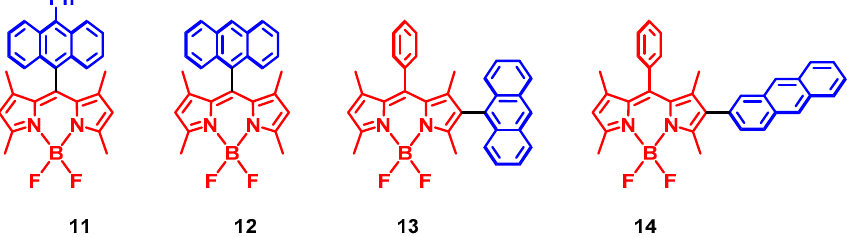
Figure 3. Anthryl-Bodipy dyads adopting orthogonal geometry but more dimensions of mutual orientation of the donor and acceptors.